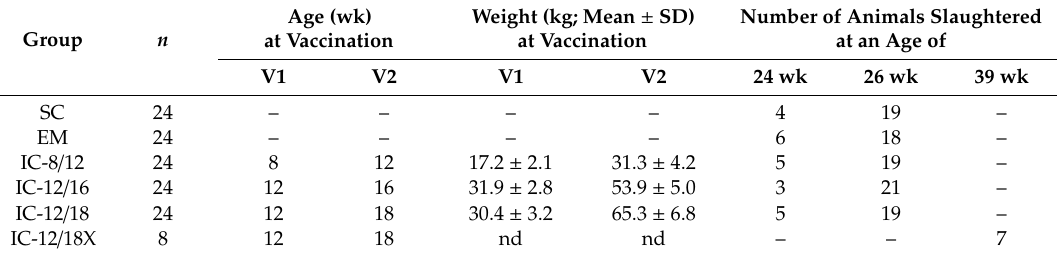
Table 1. Treatment groups, age and weight (kg; mean ± SD) at vaccination (V1, V2) and age at slaughter